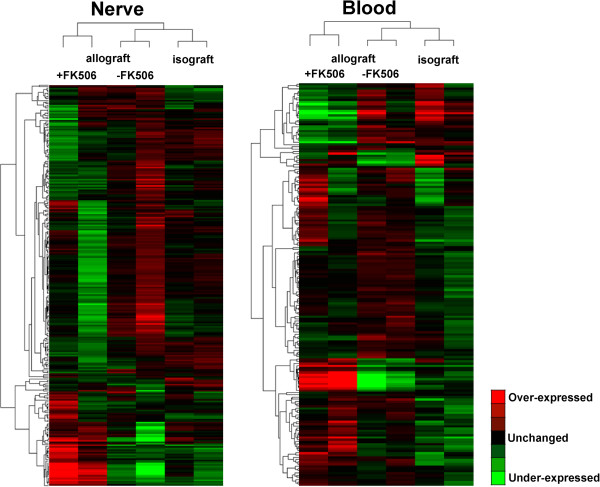
Unsupervised hierarchical clustering of the expression of miRNAs. Hierarchical clustering of miRNA differentially expressed in the whole blood and nerve grafts of Balb/c mice at postoperative day 7 with untreated isografts (Balb/c → Balb/c), (2) untreated allografts (C57BL/6 → Balb/c), and (3) allografts (C57BL/6 → Balb/c) with daily injection of 1 mg/kg FK506 for immunosuppression.